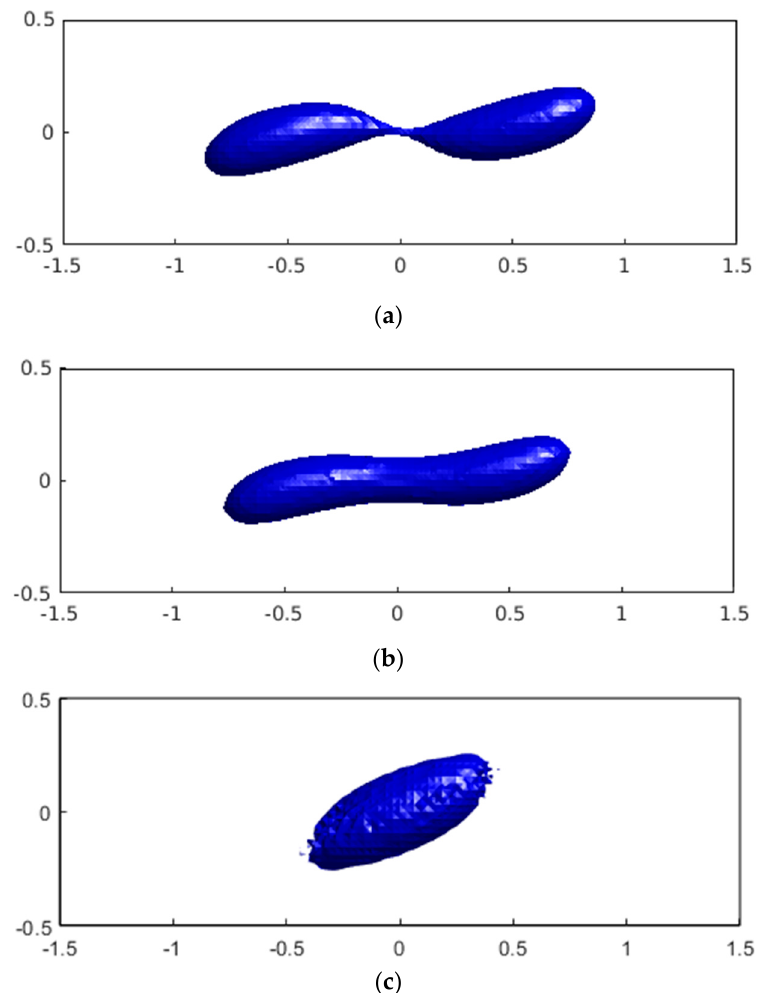
Figure 17. The shapes of the drops with the diameter of 2 𝑅 (cid:3031)(cid:3045)(cid:3042)(cid:3043) (cid:3404) 0.5 𝐻 and Ca = 0.4, ( a ): ICDR, ( b ): Mut et al. [1], ( c ): Direct re ‐ initialization